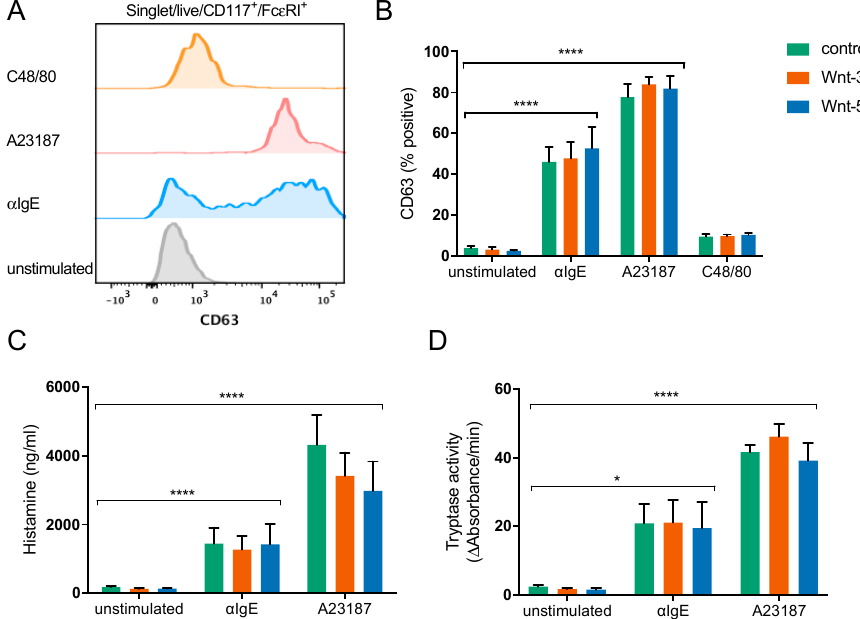
Figure 4. Mast cells cultured in the presence of purified recombinant Wnts show equal activation and release of mediators. CD34 + cells enriched from buffy coats were cultured for seven weeks under conditions that promote mast cell development, with weekly addition of 100 ng/mL Wnt-3a, Wnt-5a, or no Wnts. The cells were thereafter activated with α IgE, A23187 or compound 48/80 (C48/80) and activation was measured by CD63 surface expression using flow cytometry. A representative histogram is shown ( A ). The percentages of CD63 + cells were quantified ( B ), and histamine ( C ) and tryptase activity ( D ) was measured in the supernatant. Cells from three individual donors were analyzed in duplicate; n = 3, means with SEMs. * p < 0.05; **** p < 0.0001 .